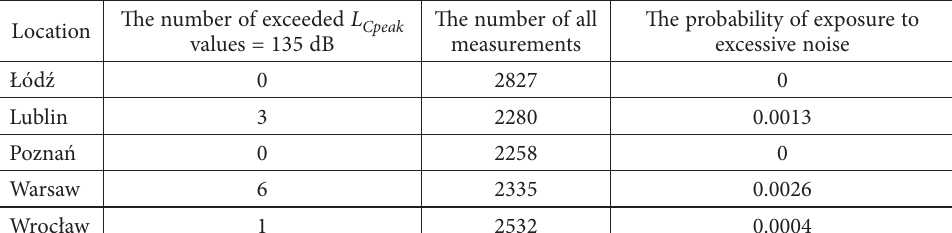
Table 1. The probability of a dangerous situation occurrence having impact on an employee’s health